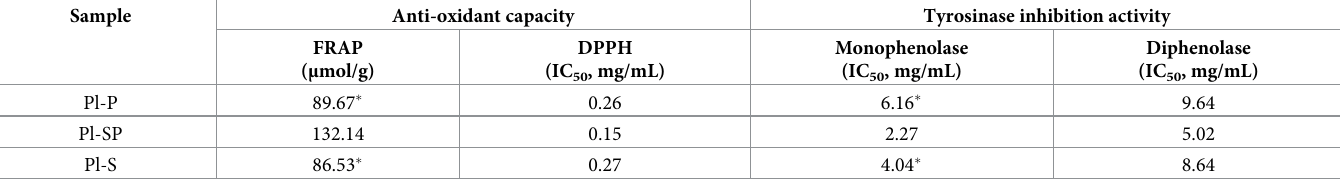
Table 2. Biological activity of petal, stamen petaloid tissue and stamen of P . lactiflora .